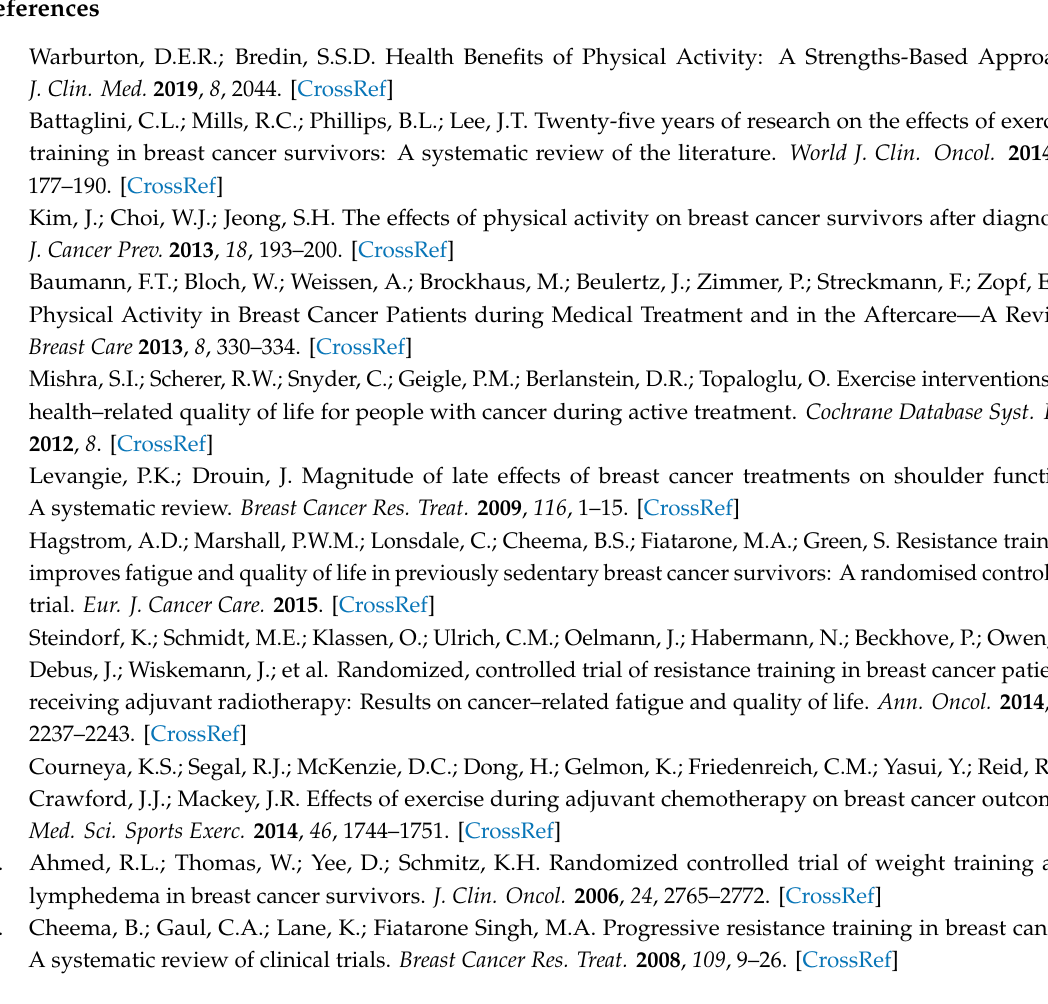
Table S1: Characteristics of controlled trials reviewed, Table S2: Outcomes, measuring tools, and main findings, Table S3: Exercise